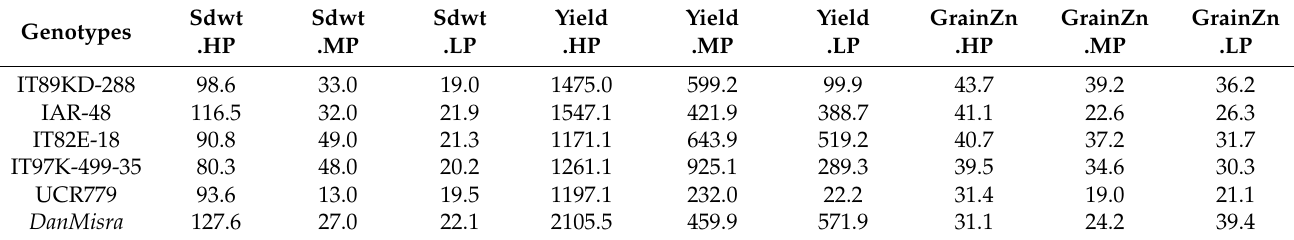
Table 3. Mean performance of representative genotypes with higher shoot dry weight, grain yield, and grain Zn content at high soil P fertilization under field